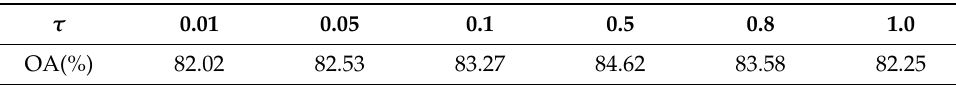
Table 4. The OA with different temperature parameter.